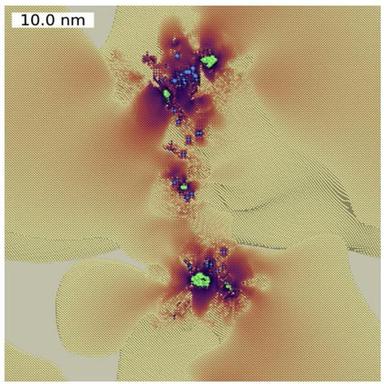
A diagonal component of the stress tensor, plotted using a color scheme reflecting the magnitude of stress, in the vicinity of radiation defects produced by a 150 keV neutron impact in pure tungsten. The green and blue spheres are the interstitial and vacancy defects, respectively, identified using the Wigner-Seitz cell analysis (image courtesy of A.E. Sand,) (For interpretation of the references to color in this figure legend, the reader is referred to the web version of this article).